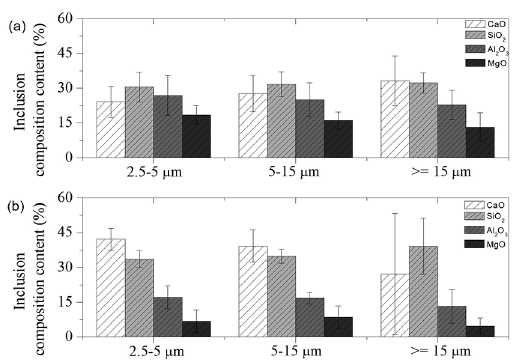
Figure 5. Inclusion and slag chemical compositions evolution before and after vacuum degassing in CaO, Al